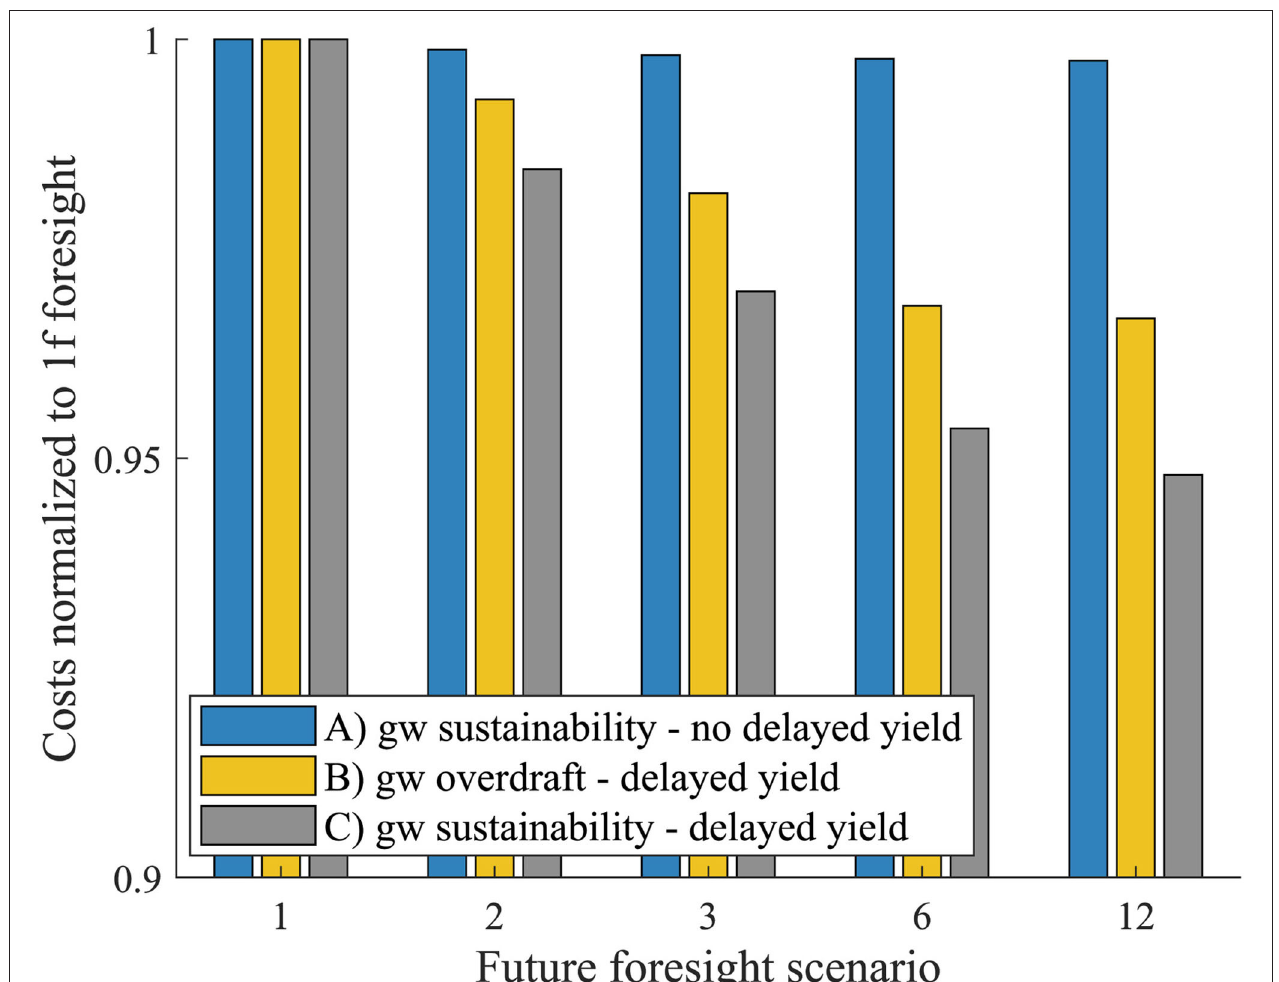
FIGURE 8 | The effect of foresight on total cost estimates from a model setup with (a) monthly yield losses in agriculture, (b) delayed yield for agricultural water allocations and groundwater overdraft, and (c) delayed yield for agricultural water allocations and sustainable groundwater allocations. All series of results are normalized to their respective “1f”